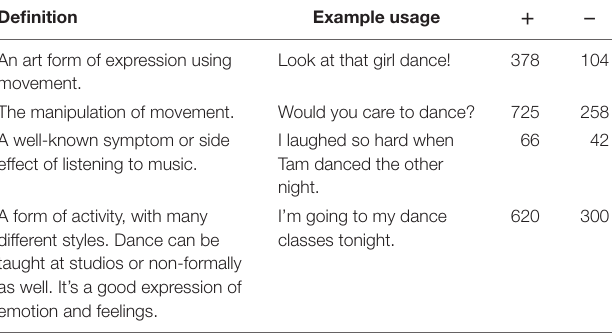
TABLE 2 | Example UD entries for the word dance.